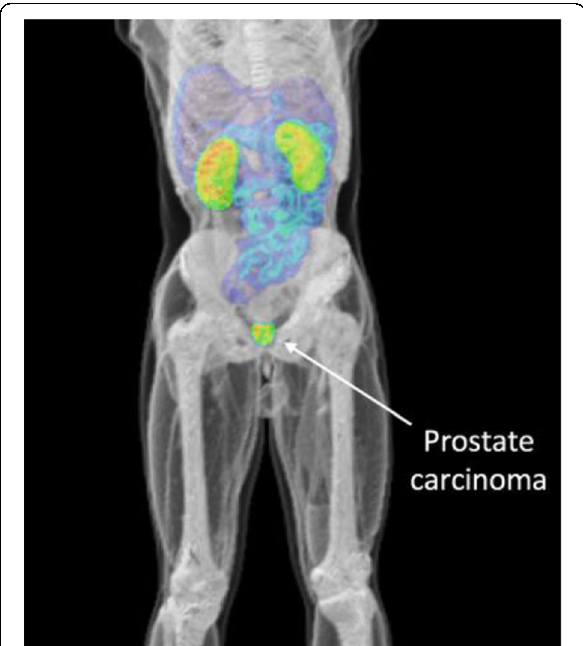
Fig. 3 (abstract A18). XCAT phantom with physiological tracer distribution and indication of prostate